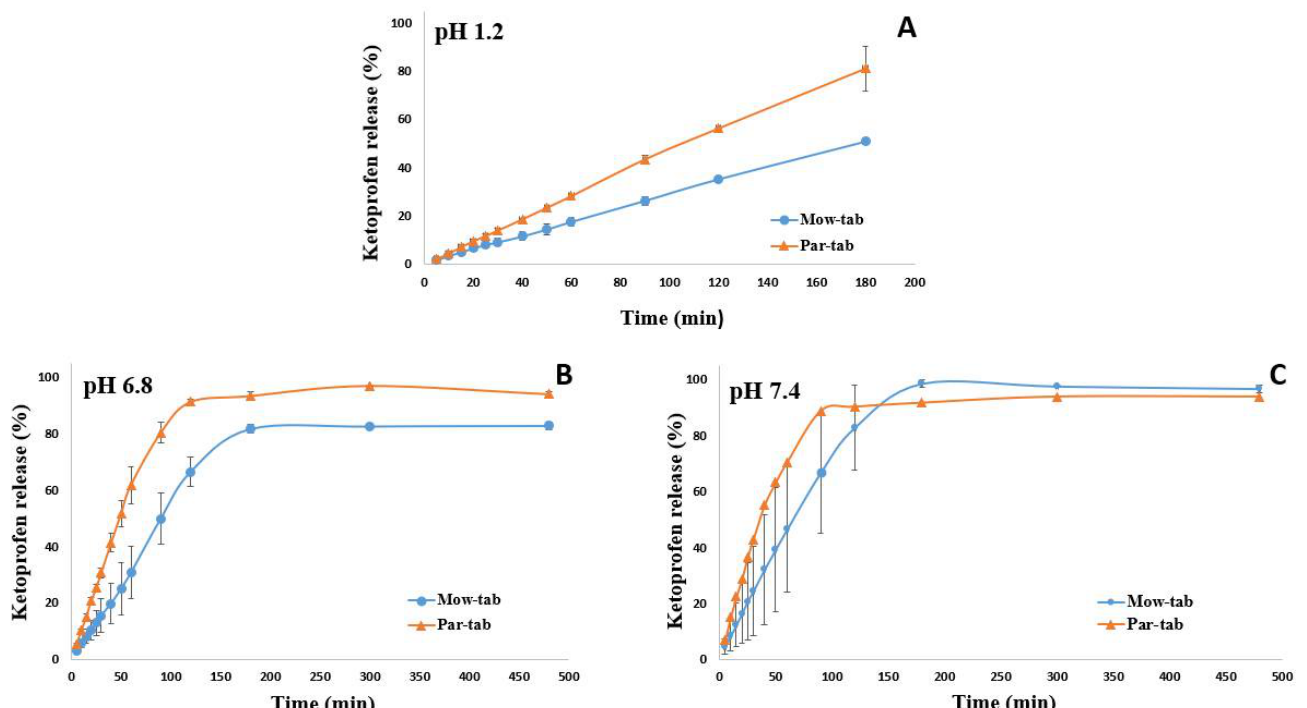
Figure 6. In vitro drug release patterns at ( A ) pH 1.2, ( B ) pH 6.8, and ( C ) pH 7.4 from 3D printed tablets.